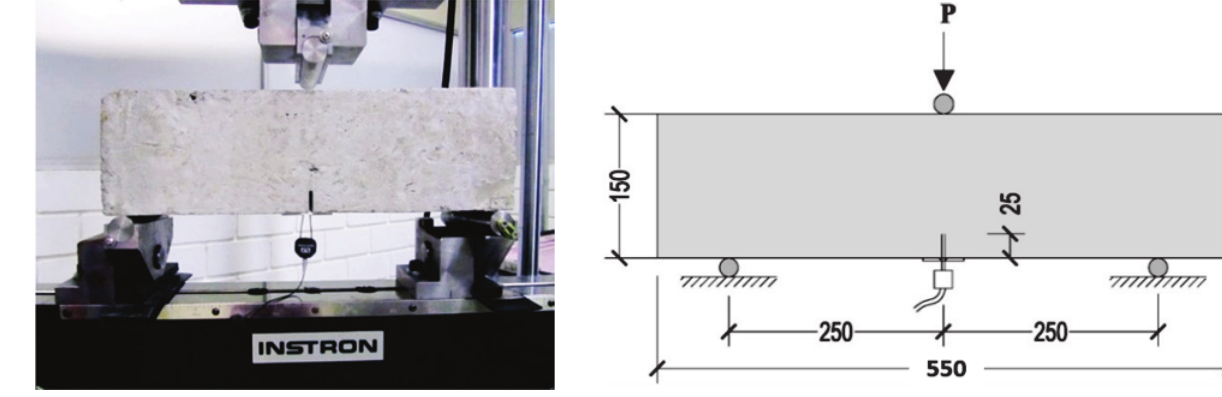
Ensaio à flexão em três pontos (EN 14651 [7]), medidas em ressaltar que o CRF é um material com elevada heterogeneidade